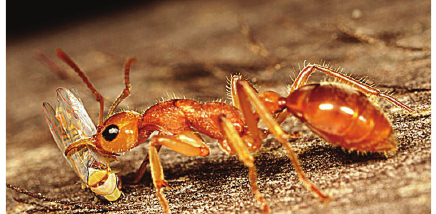
Figure 3: Nothomyrmecia macrops Clark: foraging worker with prey (male psyllid bug, Hemiptera: Psyllidae) (nocturnal, Poochera, SA, Ajay